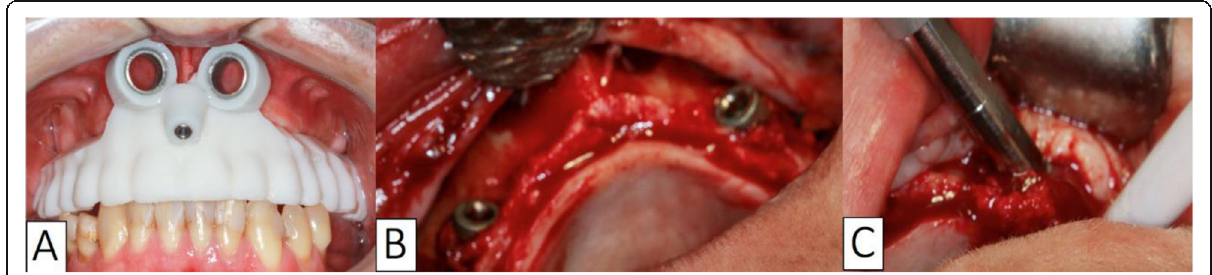
Fig. 4 Insertion of the implant. a Prototyped surgical guide installed and stabilized. b Long transmaxillary implants are placed on both sides of the maxilla. c Long transmaxillary implant placement with the final insertion using a ratchet or tufted